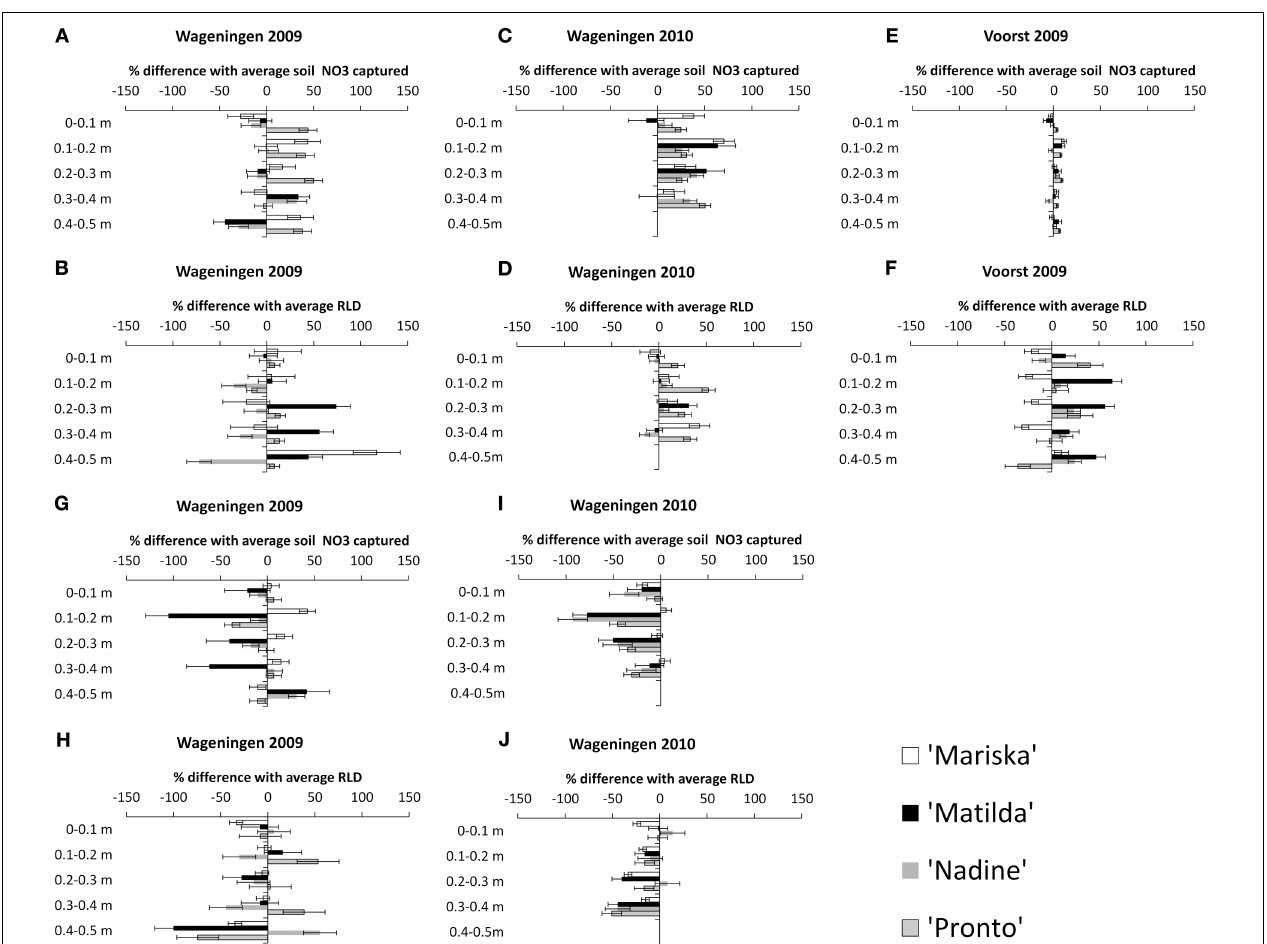
FIGURE 4 | Percentage difference in NO 3 captured in a layer with the average ∗ NO 3 captured, and percentage difference in RLD with the average RLD, for each cultivar under the “OD” transplant size (“Over-Developed” transplant size) in trial Wageningen 2009 (A and B), in trial Wageningen 2010 (C and D) and Voorst 2009 (E and F),